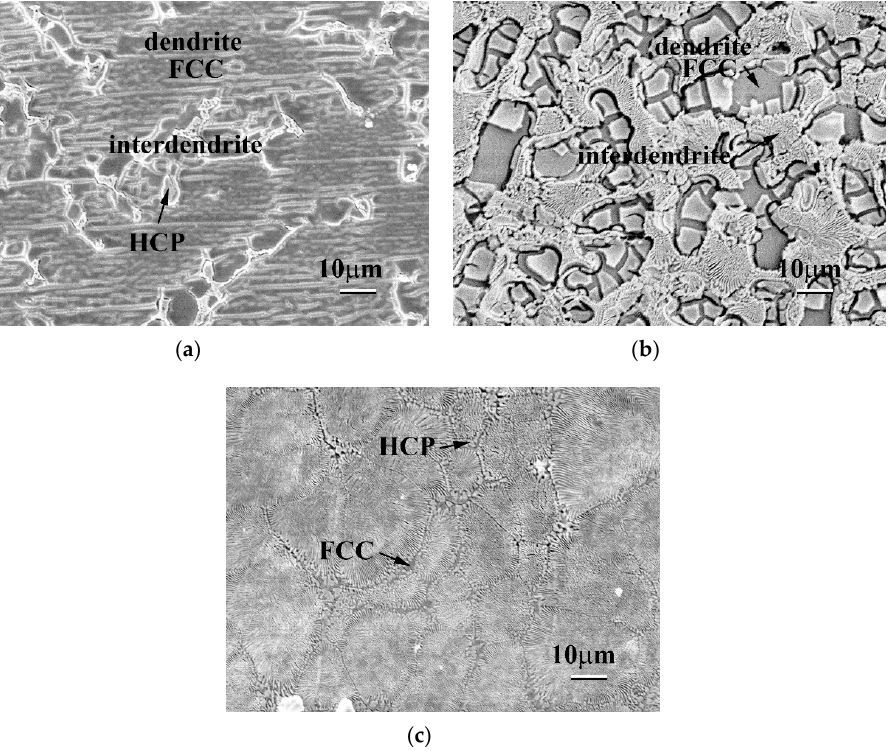
Figure 8. Surface morphologies of as-cast CoCrFeNiTa x alloys after polarization tests in 1 M NaCl solution at 30 °C. ( a ) Ta 0.1 alloy; ( b ) Ta 0.3 alloy; and ( c ) Ta 0.5 alloy.